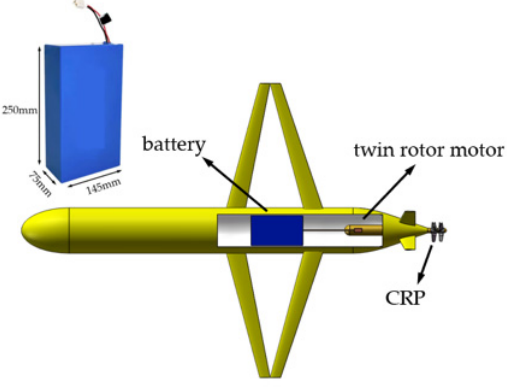
Figure 33. Concept chart of the ba tt ery and the propulsion